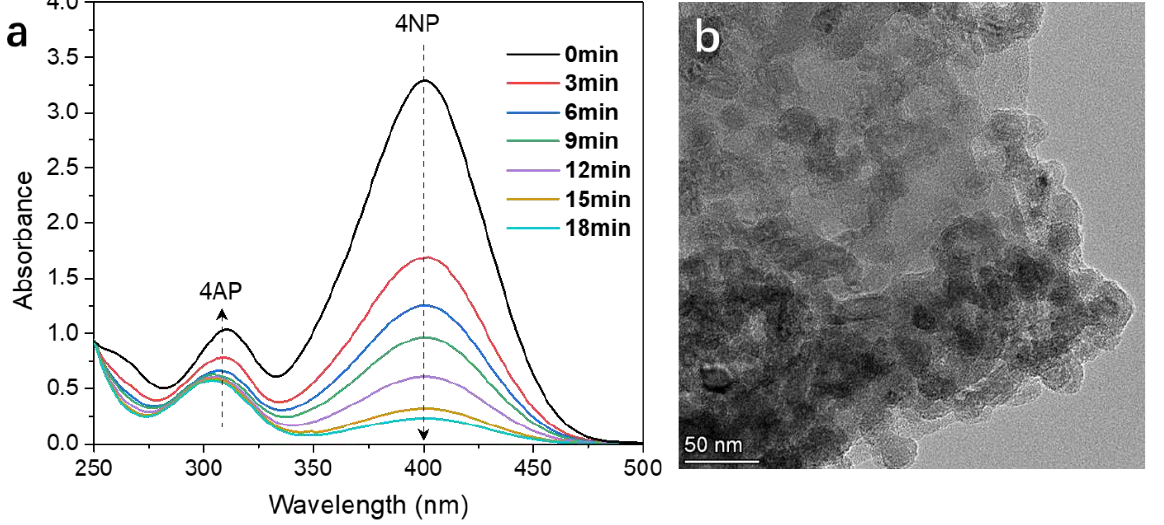
Figure 9. ( a ) Probing the catalytic activity variation after storing the ZrP@PDA/Au catalyst for six days. ( b ) TEM image of the ZrP@PDA/Au catalyst after being stored in solution for six